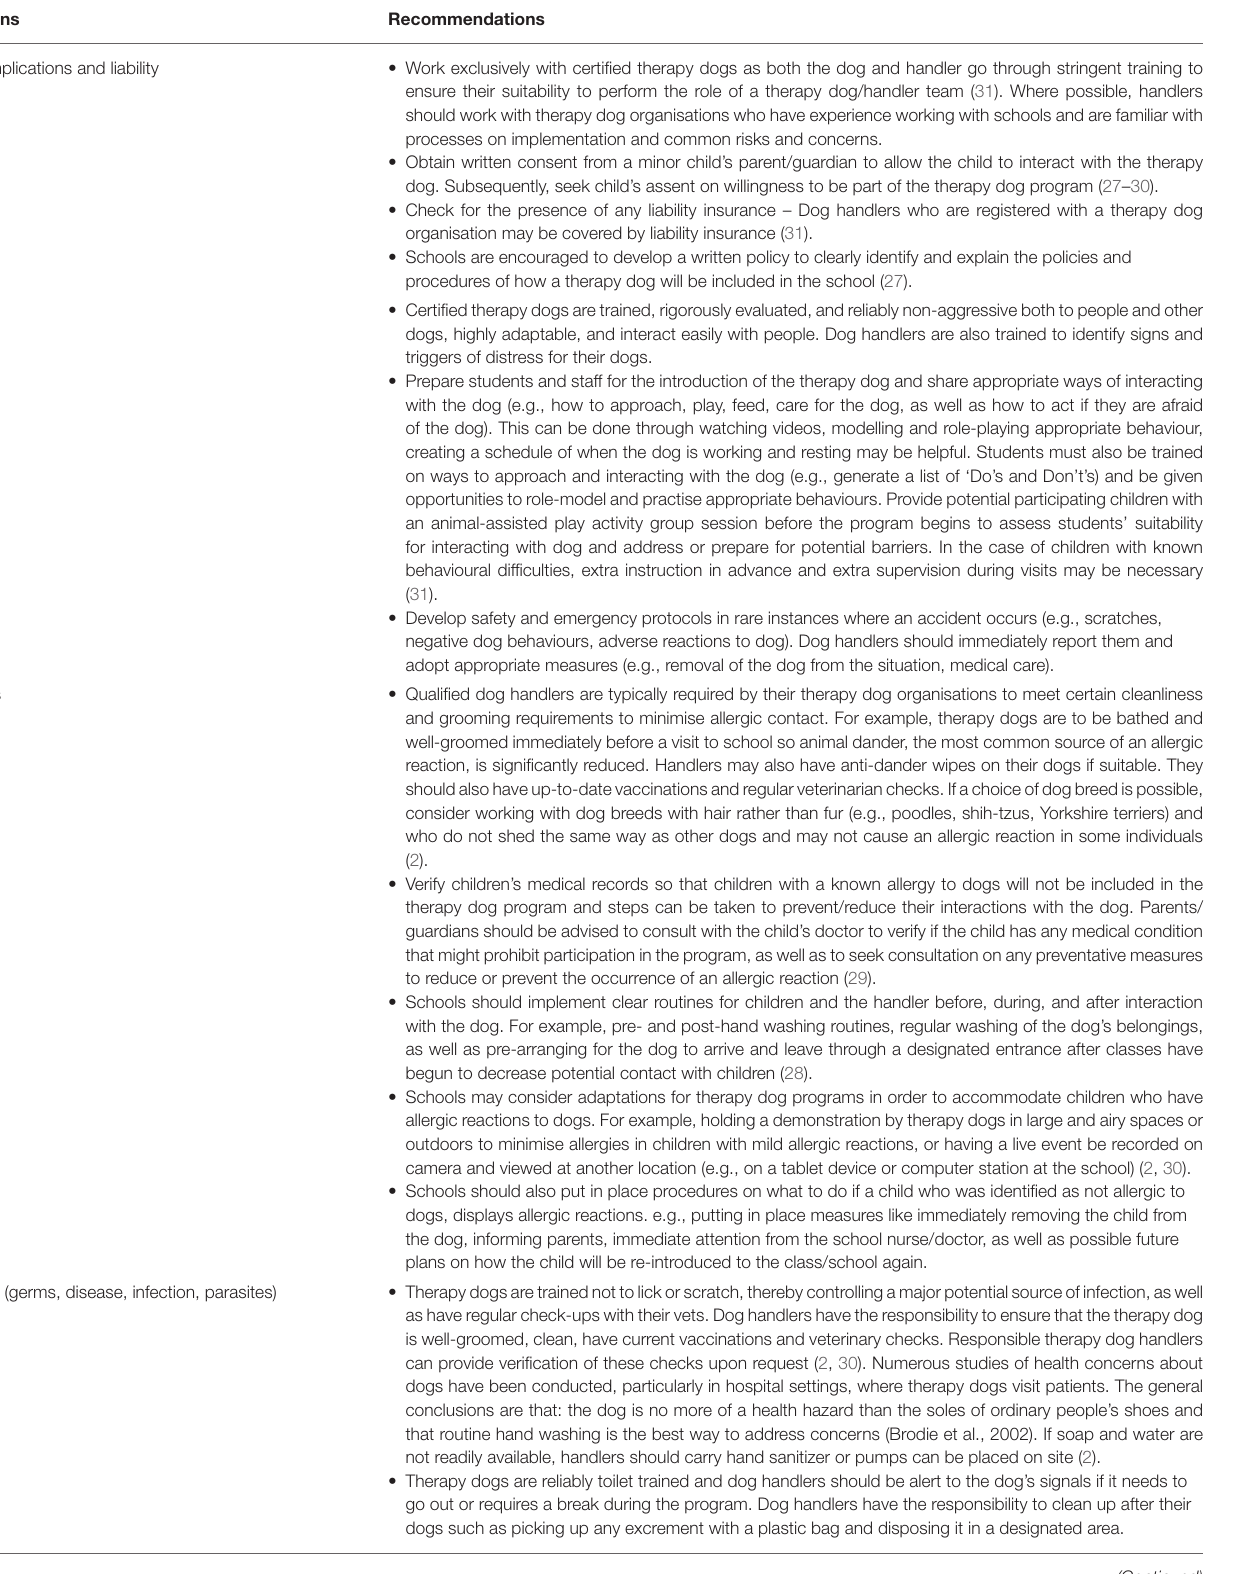
TABLE 3 | Common concerns/challenges and strategies to manage/address them.